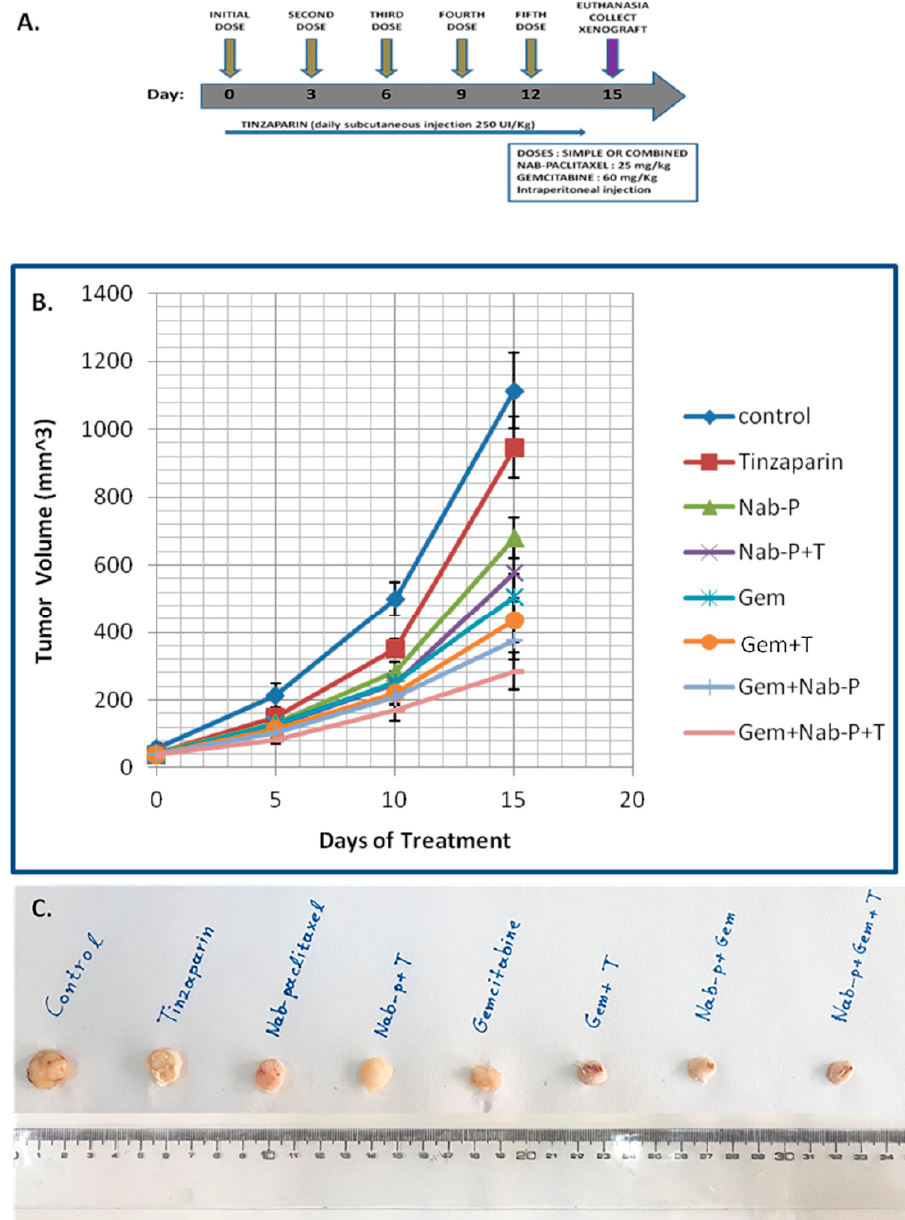
Figure 3. Tinzaparin results in tumor growth inhibition in combination with chemotherapeutic drugs in pancreatic tumor xenografts. ( A ) Mice were injected subcutaneously in the right flank with 0.1 mL PBS containing 10 6 PANC-1 human pancreatic cancer cells. After 15 days of treatment, mice were euthanized and tumors were collected for further analysis. ( B ) The diagram shows the tumor volume for each group (control, tinzaparin, nab-paclitaxel, nab-paclitaxel + tinzaparin, gemcitabine, gemcitabine + tinzaparin, nab-paclitaxel + gemcitabine, nab-paclitaxel + gemcitabine + tinzaparin) during treatment. All data represent mean ± SD, ( n = 5/group) ( C ) Representative tumors for each group with different treatments or no treatment (control).